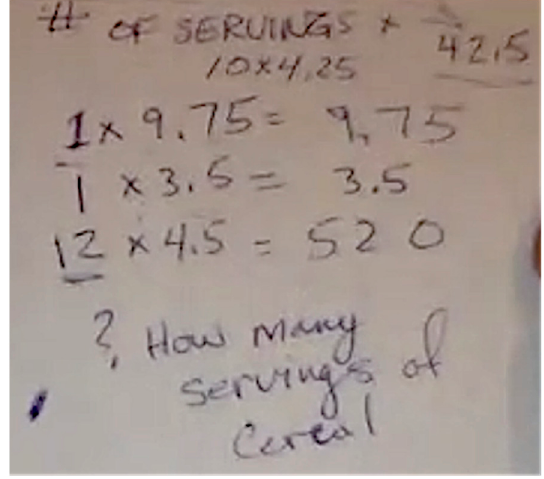
Figure 3. Kaya’s calculation.